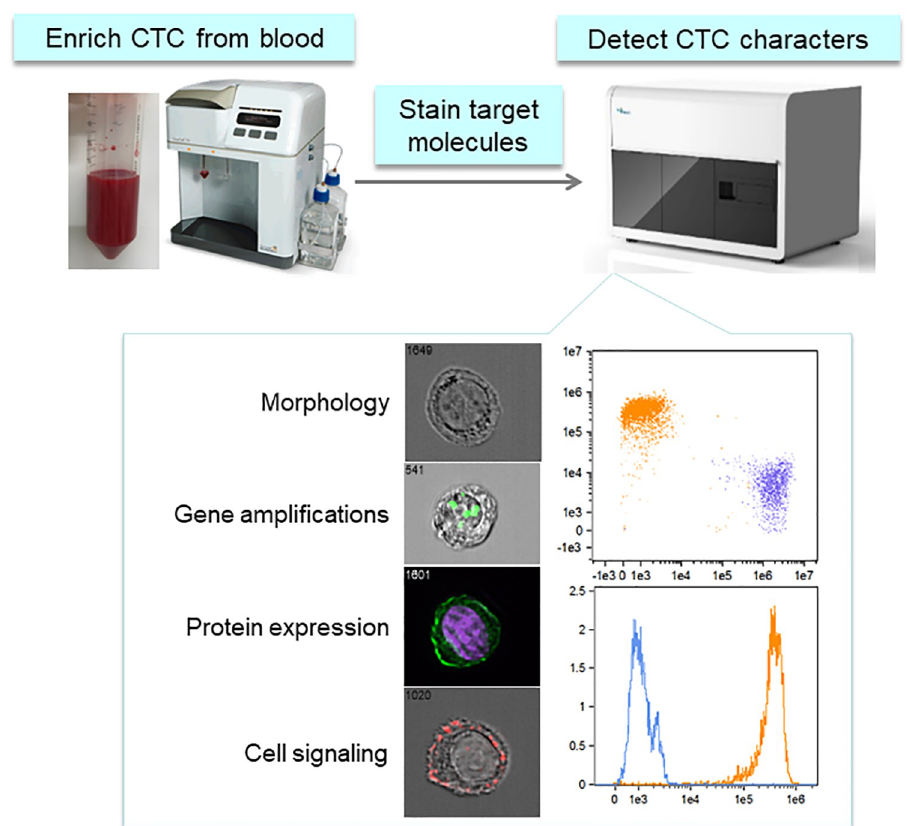
Fig 1. Image of the CTC detection system. ClearCell FX is used for CTC enrichment, and ImageStream Mark II (imaging flow cytometer) is used for CTC characterization, e.g., cell morphology, gene abnormality, protein expression, and intracellular signaling. https://doi.org/10.6084/m9.figshare.12432530.v2.